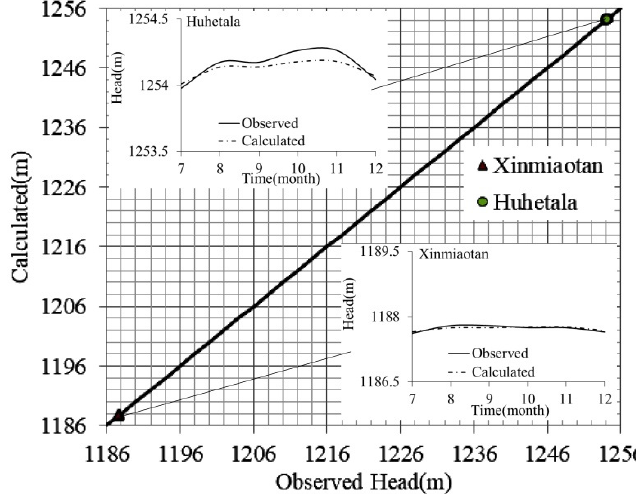
ISPRS Int. J. Geo-Inf. 2022 , 11 , x FOR PEER REVIEW Figure 6. Comparison of observed head and calculated head. Figure 6. Comparison of observed head and calculated head.